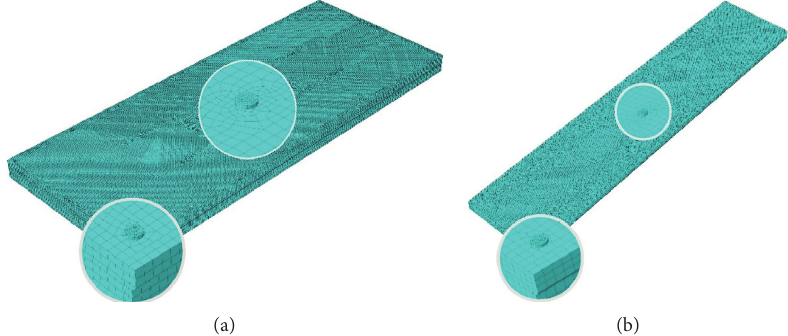
Figure 18: First FE model (refined models). (a) Single-span simply supported formwork. (b) Three-span continuous formwork.